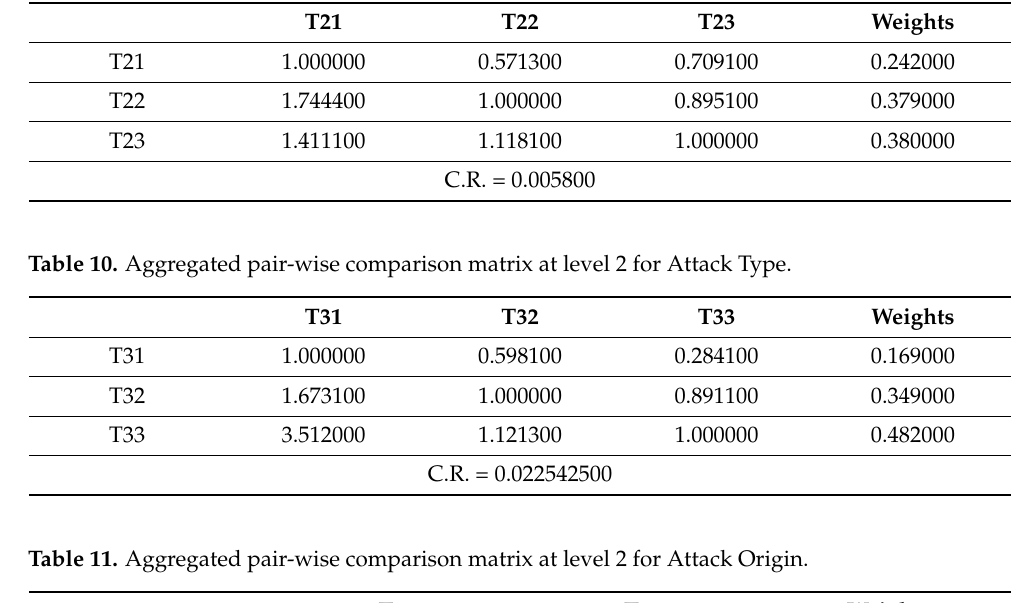
Table 9. Aggregated pair-wise comparison matrix at level 2 for CIA Compromise.